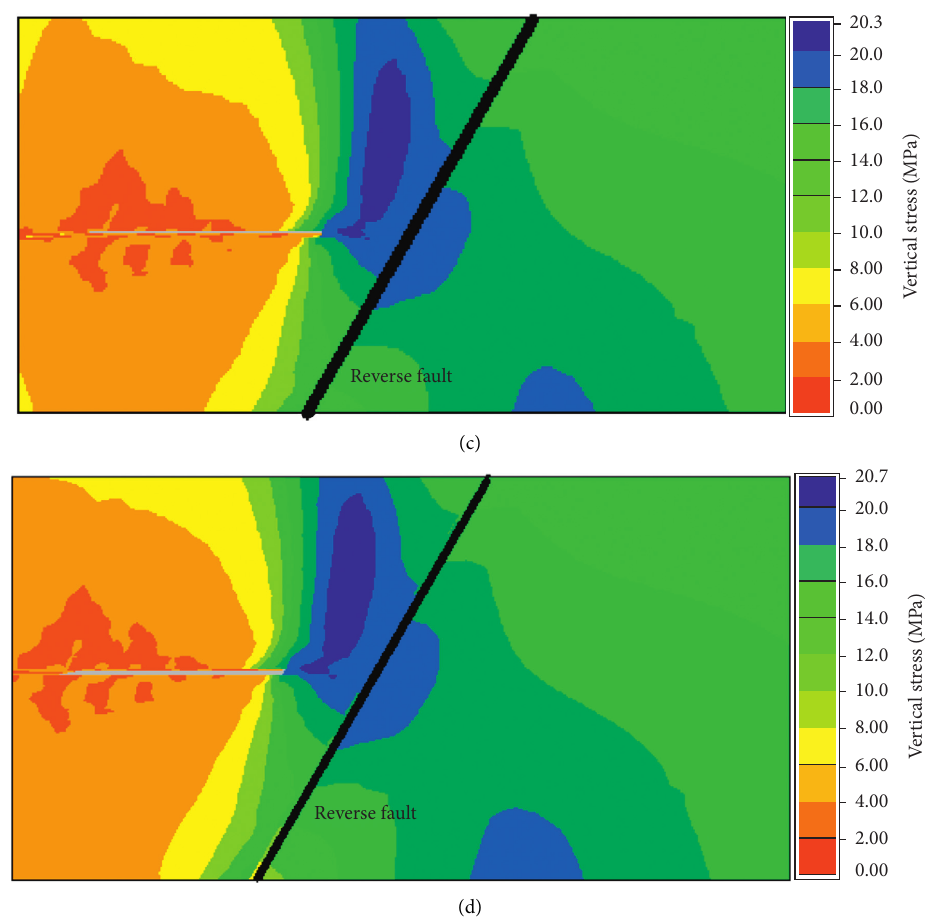
Figure 14: Stress distribution when the distance between working face and reverse fault is 10m with different fault throw. (a) The throw of reverse fault is 4m. (b) The throw of reverse fault is 10 m. (c) The throw of reverse fault is 15m. (d) The throw of reverse fault is